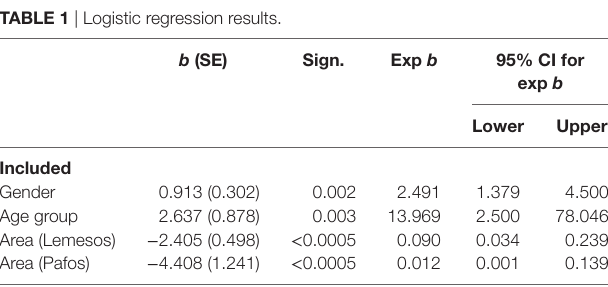
TaBle 1 | Logistic regression results.